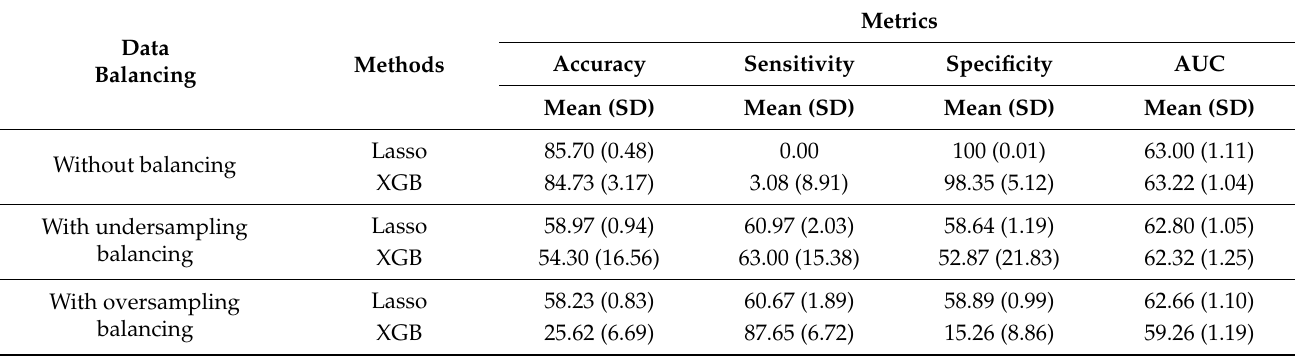
Table 2. Comparison of models with and without the balancing technique.